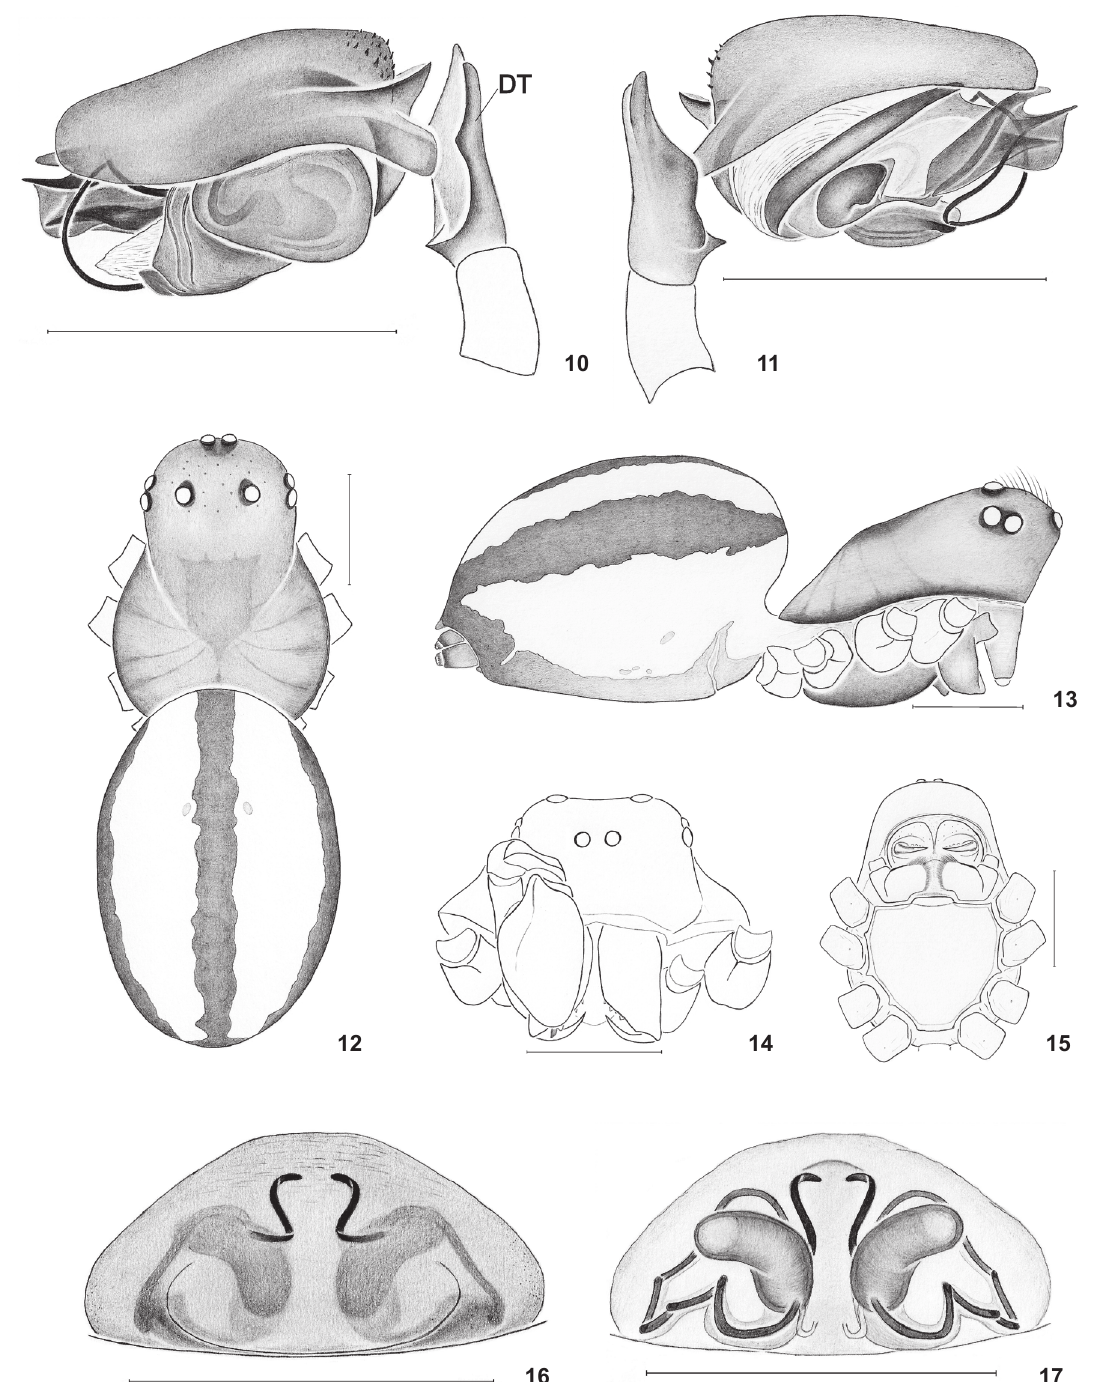
Figures 10-17. Psilocymbium lineatum . (10-11) Male palpus: (10) ectal view, (11) mesal view. (12-15) Male habitus: (12) dorsal view; (13) lateral view; (14) frontal view; (15) ventral view, sternum detail. (16-17) Epyginum: (16) ventral view; (17) dorsal view, cleared. Scale bars: 0,25